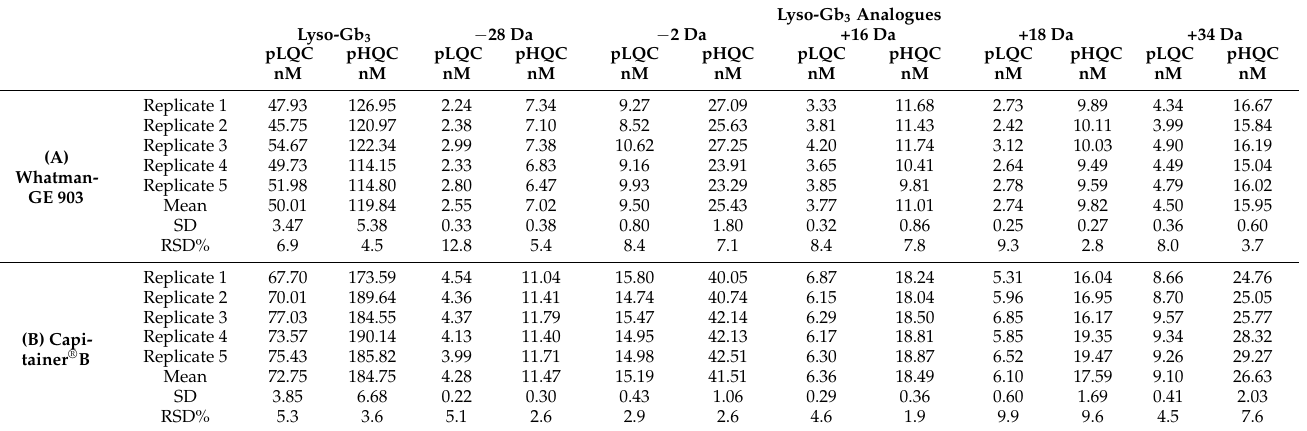
Table 2. Intra-day assays ( n = 5) performed with dried blood spots (DBSs) obtained from Fabry patients as quality controls (pQCs).